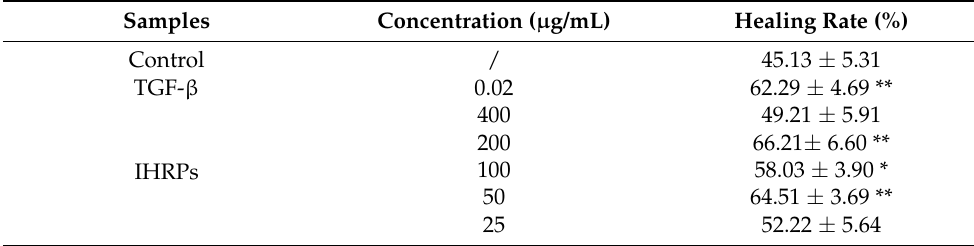
Table 6. Healing rate of HDF scratches (* p < 0.05, ** p <